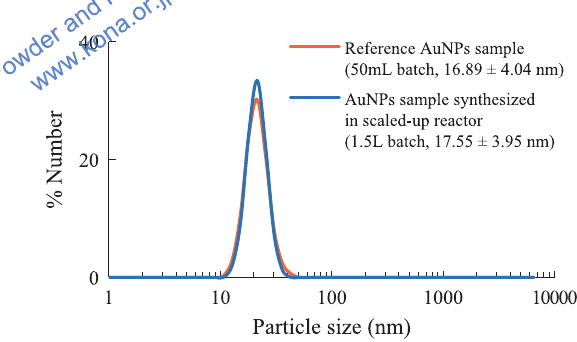
Fig. 8 Batch size had a minimum effect on the particle size and size distribution of AuNPs synthesized under the given conditions. (System: 0.25 ml HAuCl 4 , 1 wt% NaCt, MR = 2.80, 100 °C reaction temperature).